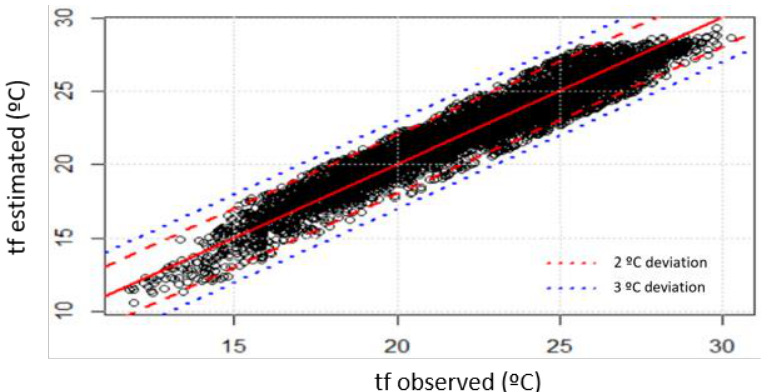
Figure 7. Comparison between values observed and estimated.